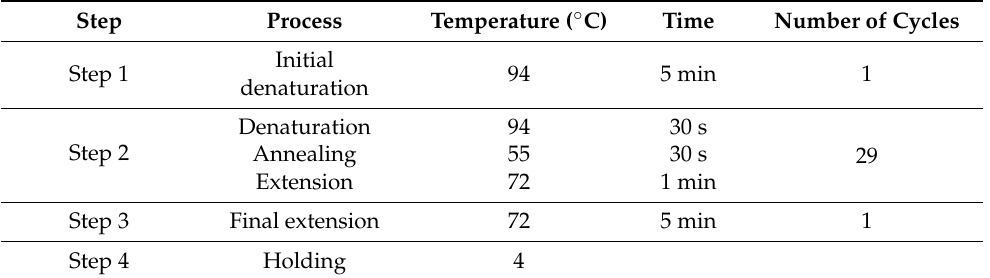
Table 2. Polymerase chain reaction (PCR) cycling steps [25].